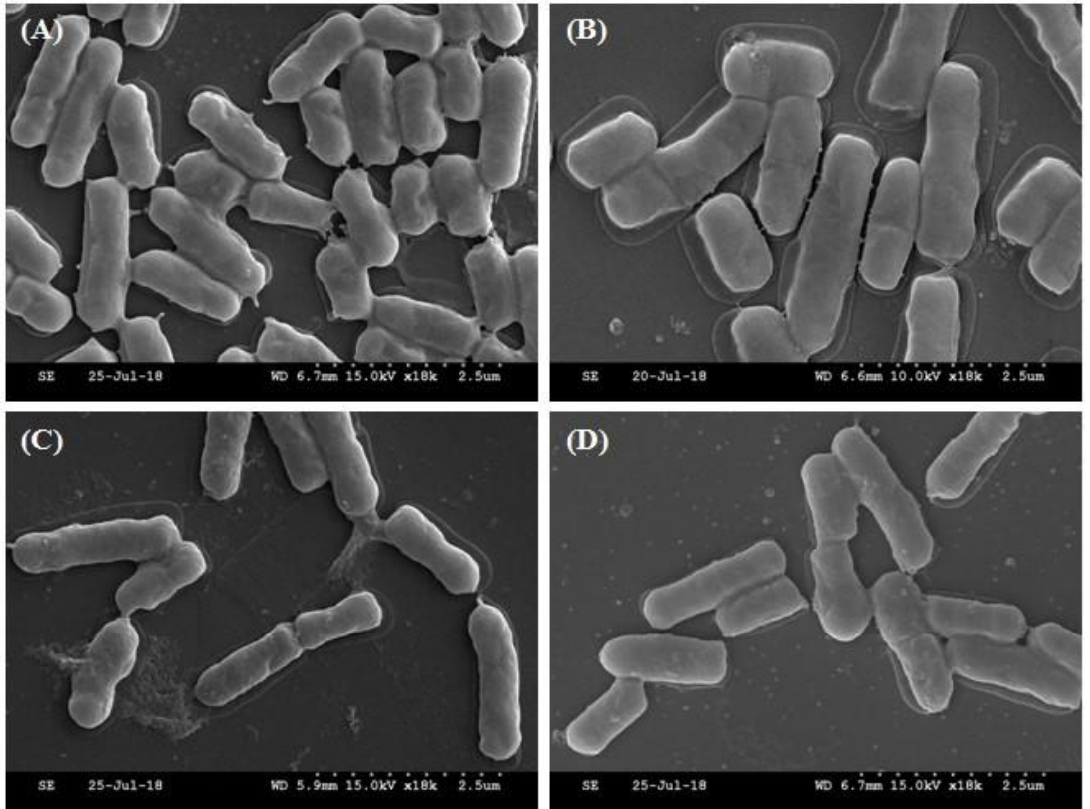
Figure 3. The scanning electron microscope (SEM)images of selected strains:( A ) Lactobacillus plantarum MG4221; ( B ) L. fermentum MG4231; ( C ) L. fermentum MG4261; and( D ) L. plantarum MG4270.